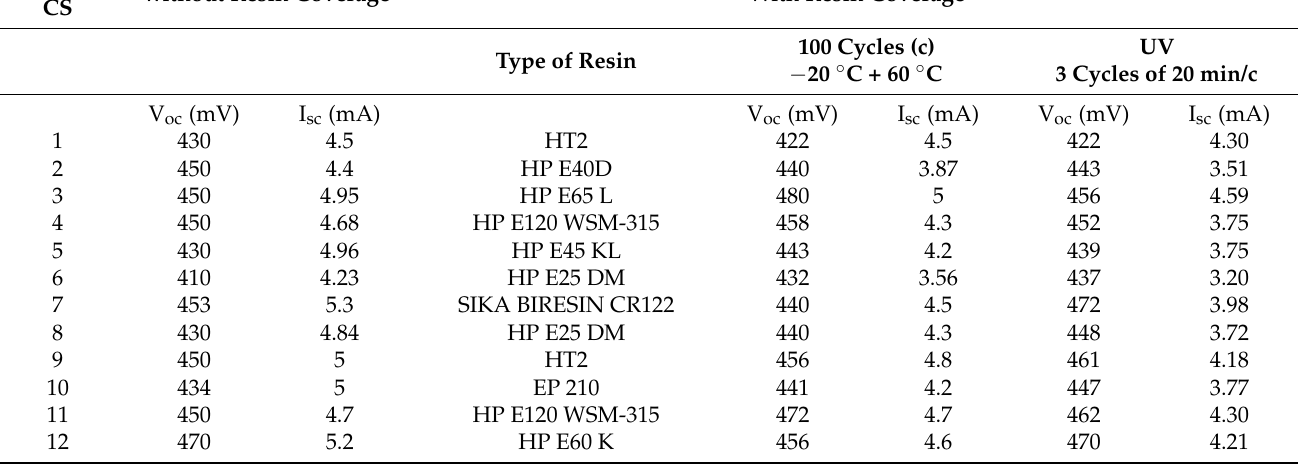
radiation testing. Table 1. Main parameters of the photovoltaic cells measured before and after the mechano-climatic tests. Legend: 100 ther- mal cycles − 20 ◦ C to +60 ◦ C and 3 cycles UV exposure 20 min each: c—number of cycles, T—temperature exposure, UV—ultraviolet exposure. Based on the mechanical and optical properties, the epoxy resin that was selected was HT 2, (produced by R&G Faserverbundwerkstoffe GmbH, 71111 Waldenbuch, Germany).